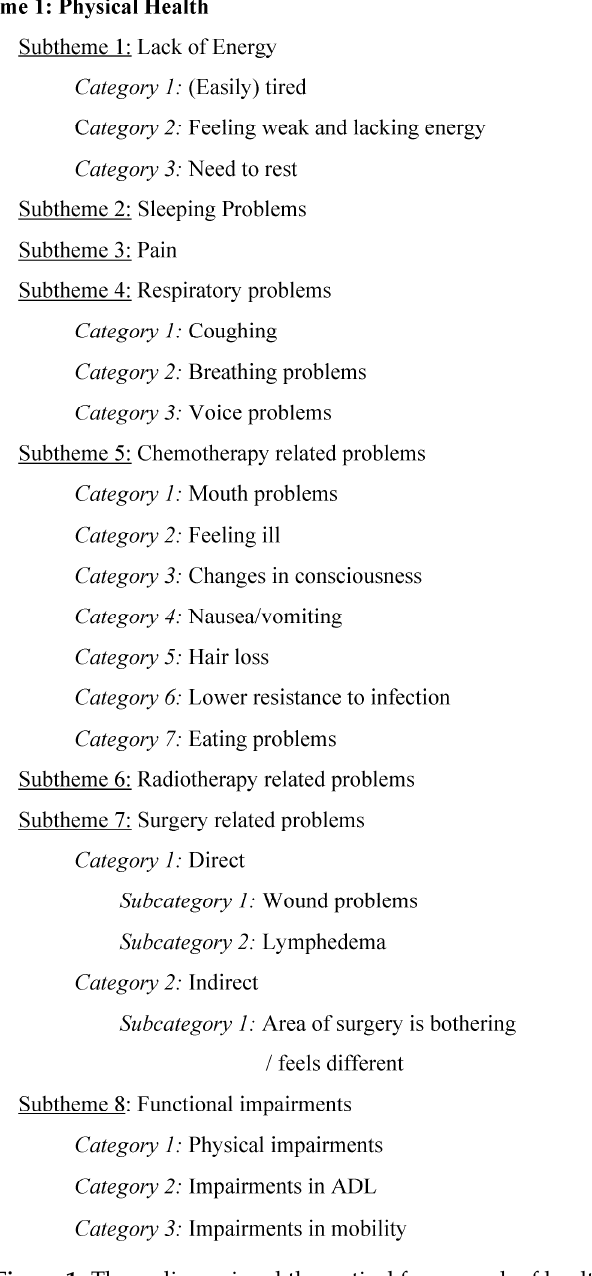
Figure 1. Three-dimensional theoretical framework of health for thoracic sarcoma patients and the different subthemes within the main themes physical, mental, and social health based on the biopsychosocial model.